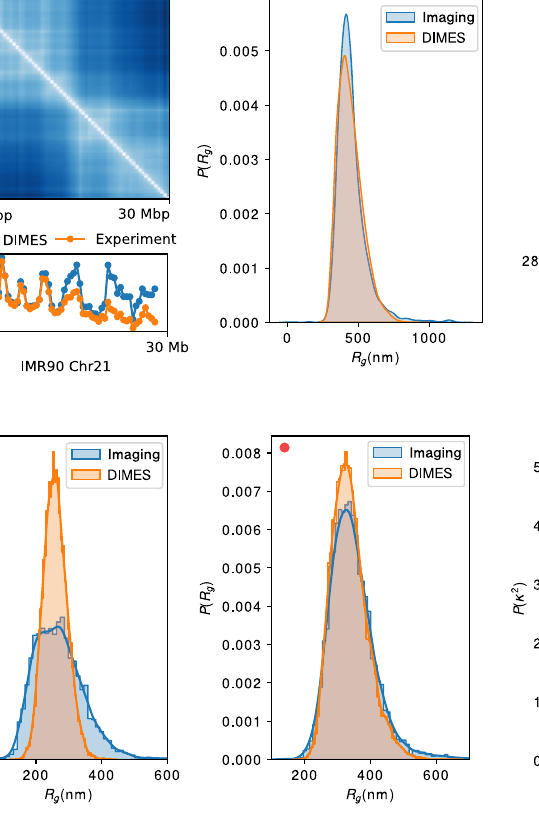
Fig. 10. c The heatmaps of the JSD of the distribution of R g and κ 2 between the experiment and the calculations. Each element ( i , j ) in the heatmap is the value of JSD for the segment that starts from i th loci and ends at j th loci. Red and blue lines represent two such segments. d Comparison of P ( R g ) and P ( κ 2 ) between the pre- dictions using DIMES and those calculated using experiments for the segments marked in( c ).The blue (red) dotonthe leftcorner of eachsub- fi gureindicatesthe locations of the